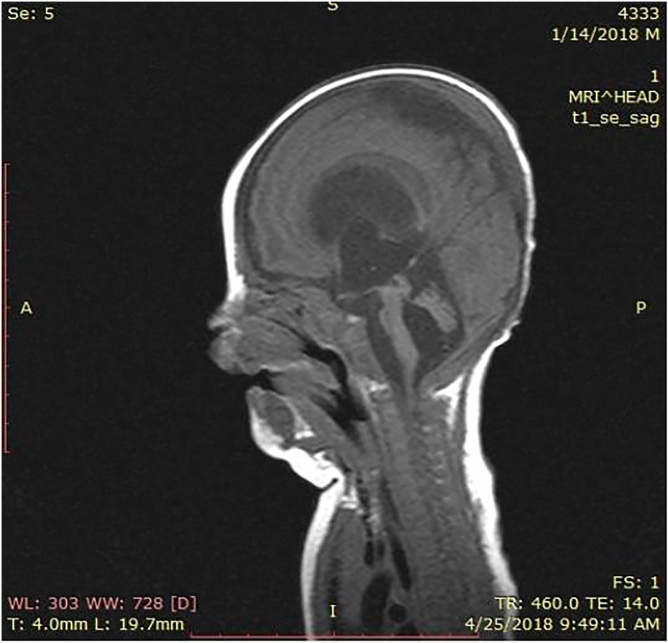
MRI scan, sagittal view, demonstrating the hypoplasia of the cerebellum and of the posterior fossa.